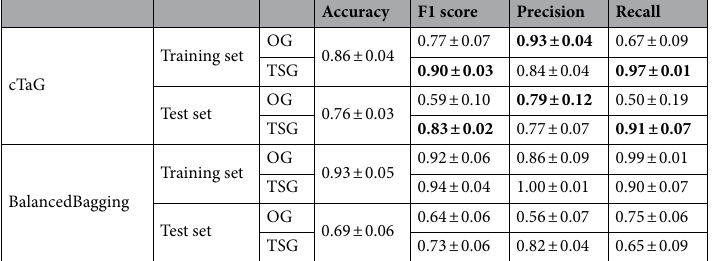
Table 3. Classification metrics for training and test set. Numbers in bold indicate best performances for each metric between TSG and OG. The metrics are standard, and are defined as follows (T stands for True, F for false, P for positives and N for negatives): Accuracy = (TP + TN)/(TP + FP + TN + FN); Precision = TP/(TP + FP); Recall = TP/(TP + FN); F1 score is the harmonic mean of Precision and